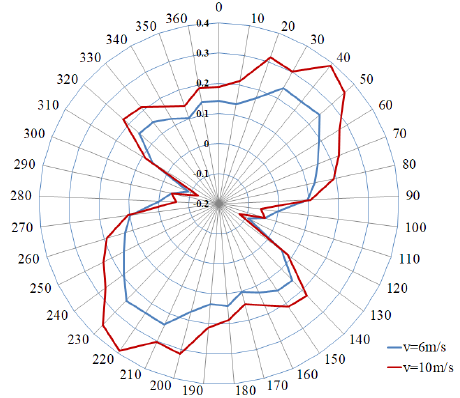
Figure 10. Radar chart of C ts of 2-bladed LDCS as a function of azimuth.